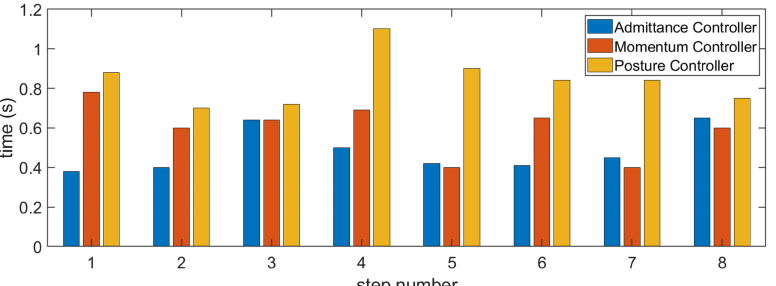
Figure 12. Different controller convergence times. Most of the time, the admittance controller converges first, then the momentum controller, and finally the posture